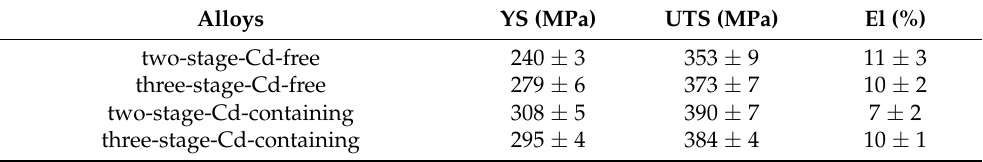
Figure 6. Stress-strain curves of the Cd-free and Cd-containing alloys after two-stage and three- stage heat treatment. Table 3. Mechanical properties of the Cd-free and Cd-containing alloys after T6 heat treatment.